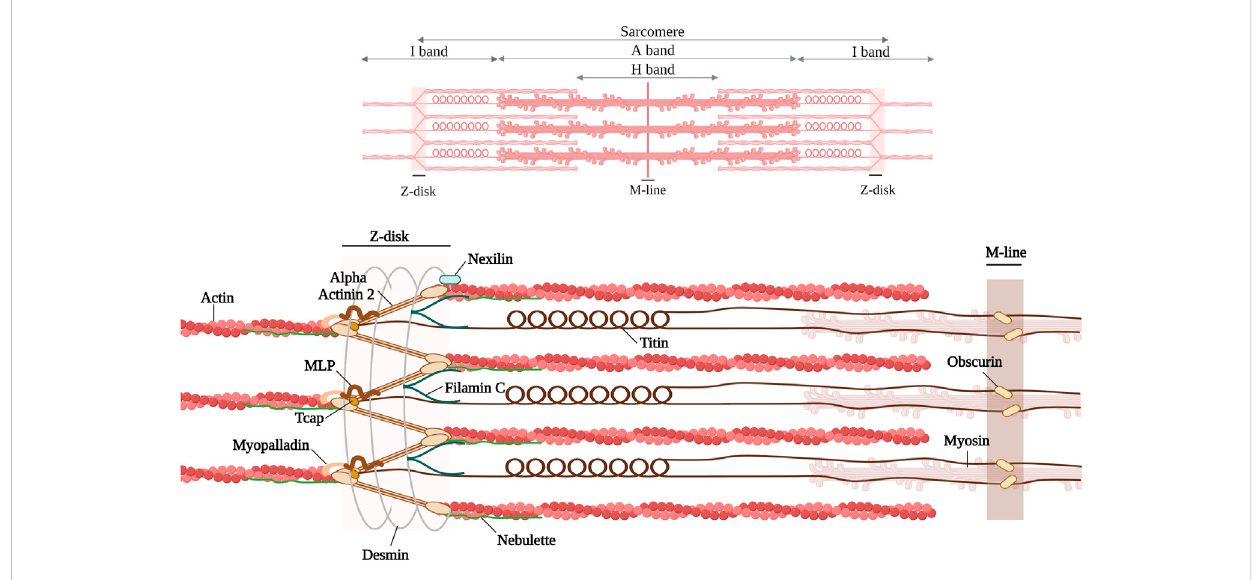
FIGURE 1 Schematic representation of the discussed Z-disk proteins (alpha-actinin 2, Filamin C, Titin, muscle LIM protein, telethonin, myopalladin, nebulette, nexilin) and Z-disk associated proteins (desmin and obscurin). Created with BioRender.com. Adapted from (Pyle and Solaro, 2004; Mukund and Subramaniam,